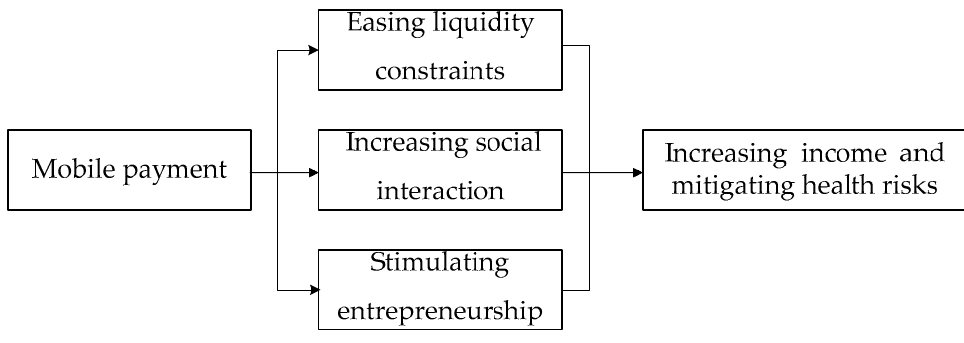
Figure 3. Theoretical analysis framework.